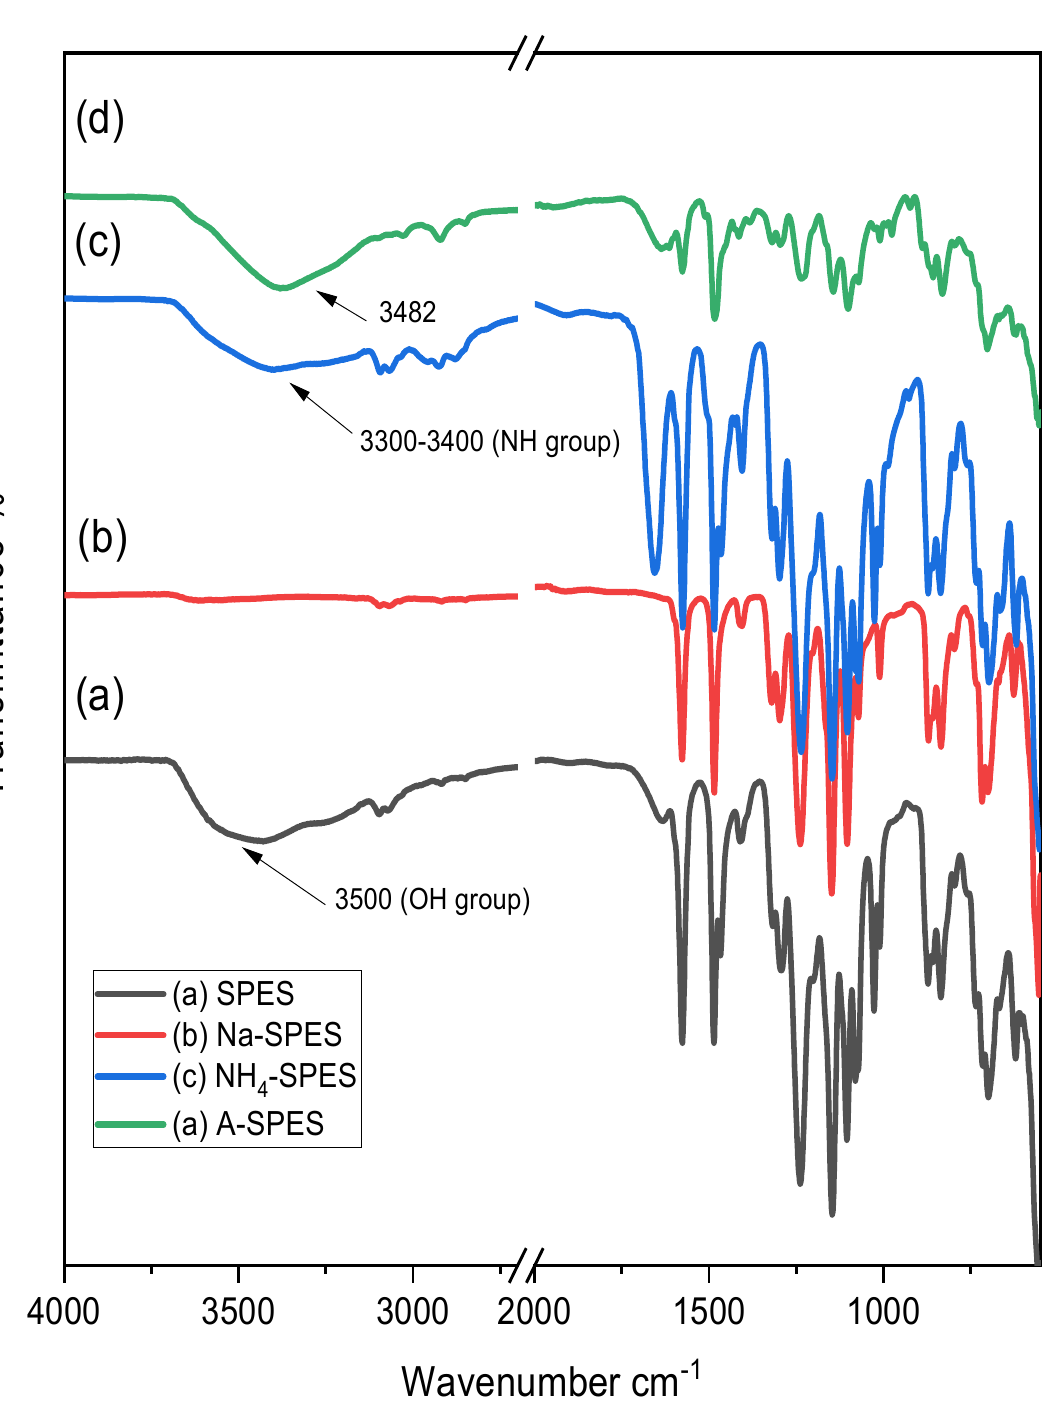
Figure 2. The spectra of FT-IR for ( a ): pure SPES, ( b ): NH 4 -SPES, ( c ): A-SPES, and ( d ): Na-SPES. The SEM photos for the SPES surface show that the pores are distributed throughout the membrane after sulfonation, whereas the Na-SPES, NH 4 -SPES, and A-SPES membranes exhibit more uniform and homogeneous surfaces [10]. Thus, the pictures demonstrate how the SPES content affects the porous structure. Based on the images observed, Figure 2 also shows that the surface changed from rough to smooth with the incorporation of Na + , NH 4+ , and A into SPES. It is important to mention that the modification of SPES into sodium, ammonium, and amberlite SPES plays an essential role in membrane formation. The development of cracks indicates that polymer chains become entangled